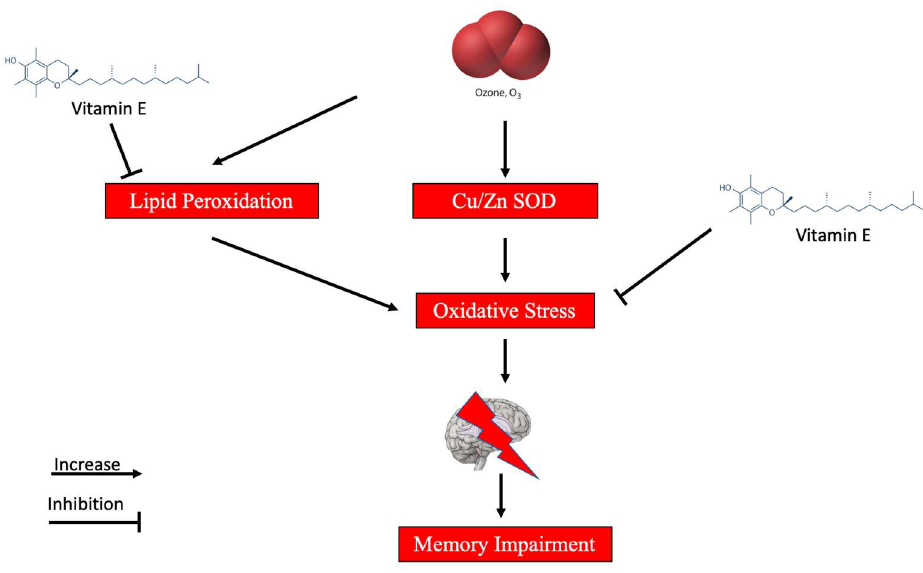
Figure 4. A schematic representation of the possible mechanisms of action of ozone on the CNS.